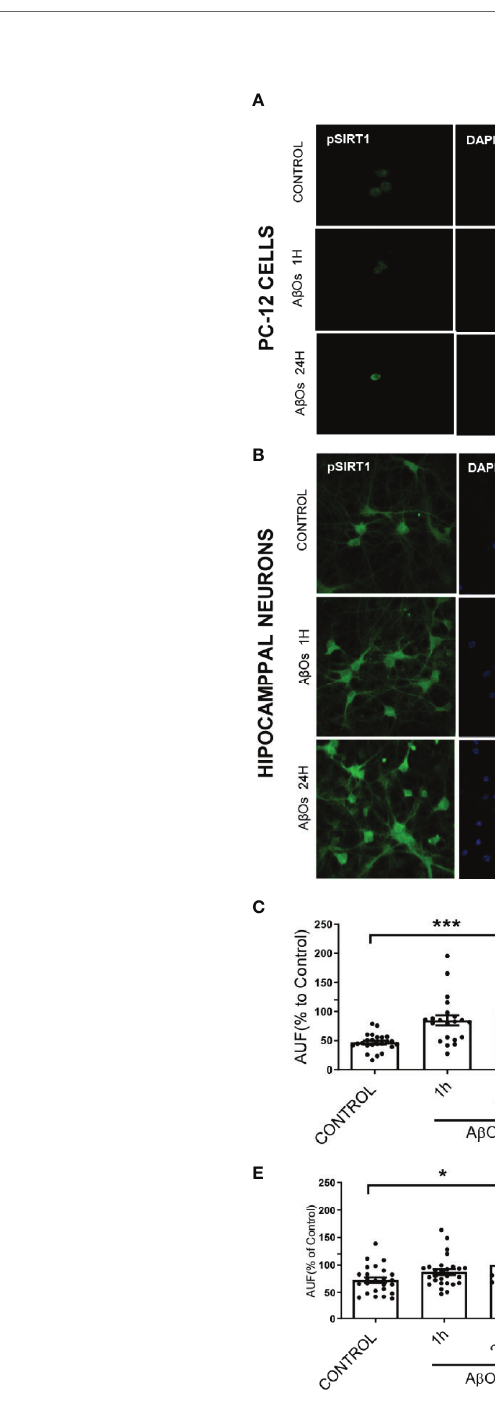
FIGURE 10 | Immunocytochemistry to evaluate p-SIRT1 distribution in PC12 cells and hippocampal neurons treated with A b Os. Representative confocal images of (A) PC12 cells and (B) hippocampal neurons showing the immunoreactivity of speci fi c primary antibodies for ph-SIRT1 (green) and DAPI (blue) in control condition (upper panel) and after A b Os treatment (0.5 µM) during different incubation times (1, 24 h lower panels). (C) Quanti fi cation of the total levels of ph-SIRT1 (lower left panel) and Quanti fi cation of the relation of nuclear and cytosolic (N/C) of p-SIRT1 in PC-12 cells (D) . (E) Quanti fi cation of the total levels of ph-SIRT1 (left corner panel) and quanti fi cation of the relation of nuclear and cytosolic (N/C) of p-SIRT1 in hippocampal neurons (F) expressed as percentage of control. Scale bars: 20 m m. Data are represented as mean ± SEM. *p< 0.05, **p < 0.01 ***p < 0.001 compared between the control group. One-way ANOVA with the Dunnett's multiple comparisons test was used for all statistical analyses. SIRT1, silent information regulator 2 homolog 1. [n=3, N=18 – 27 (Complete inmunocytochemistry with controls are provided in Supplementary Figure 10